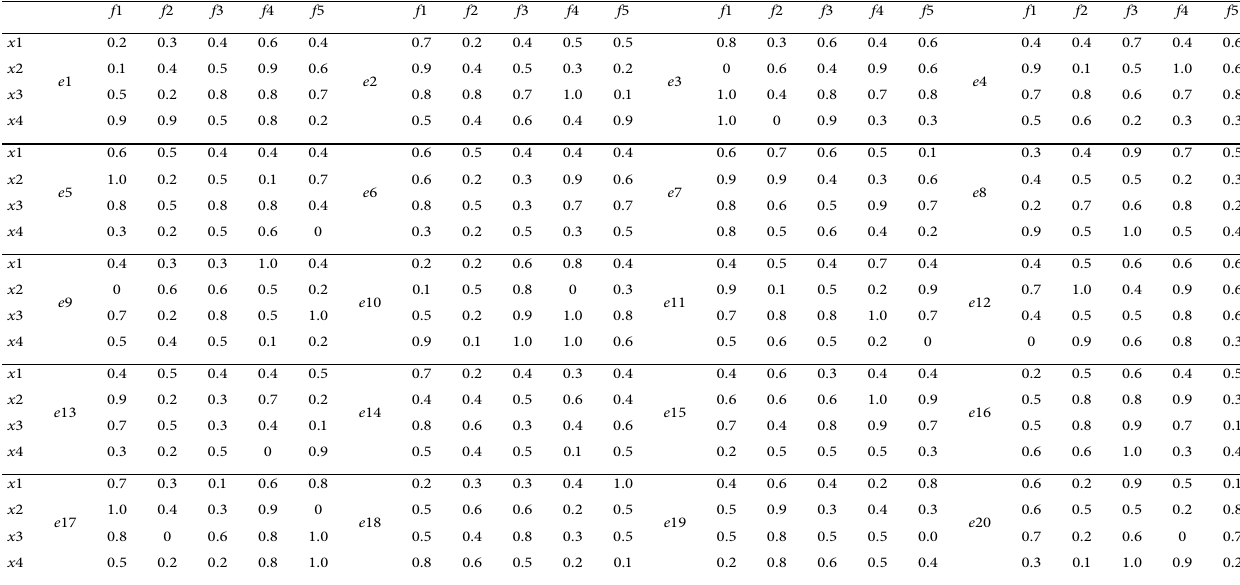
Table 27: .e values of θ +